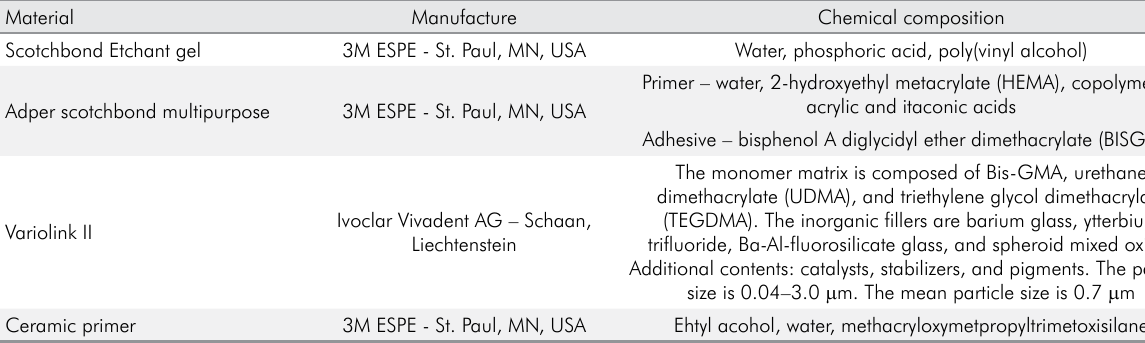
Table 2. Commercial materials used in this